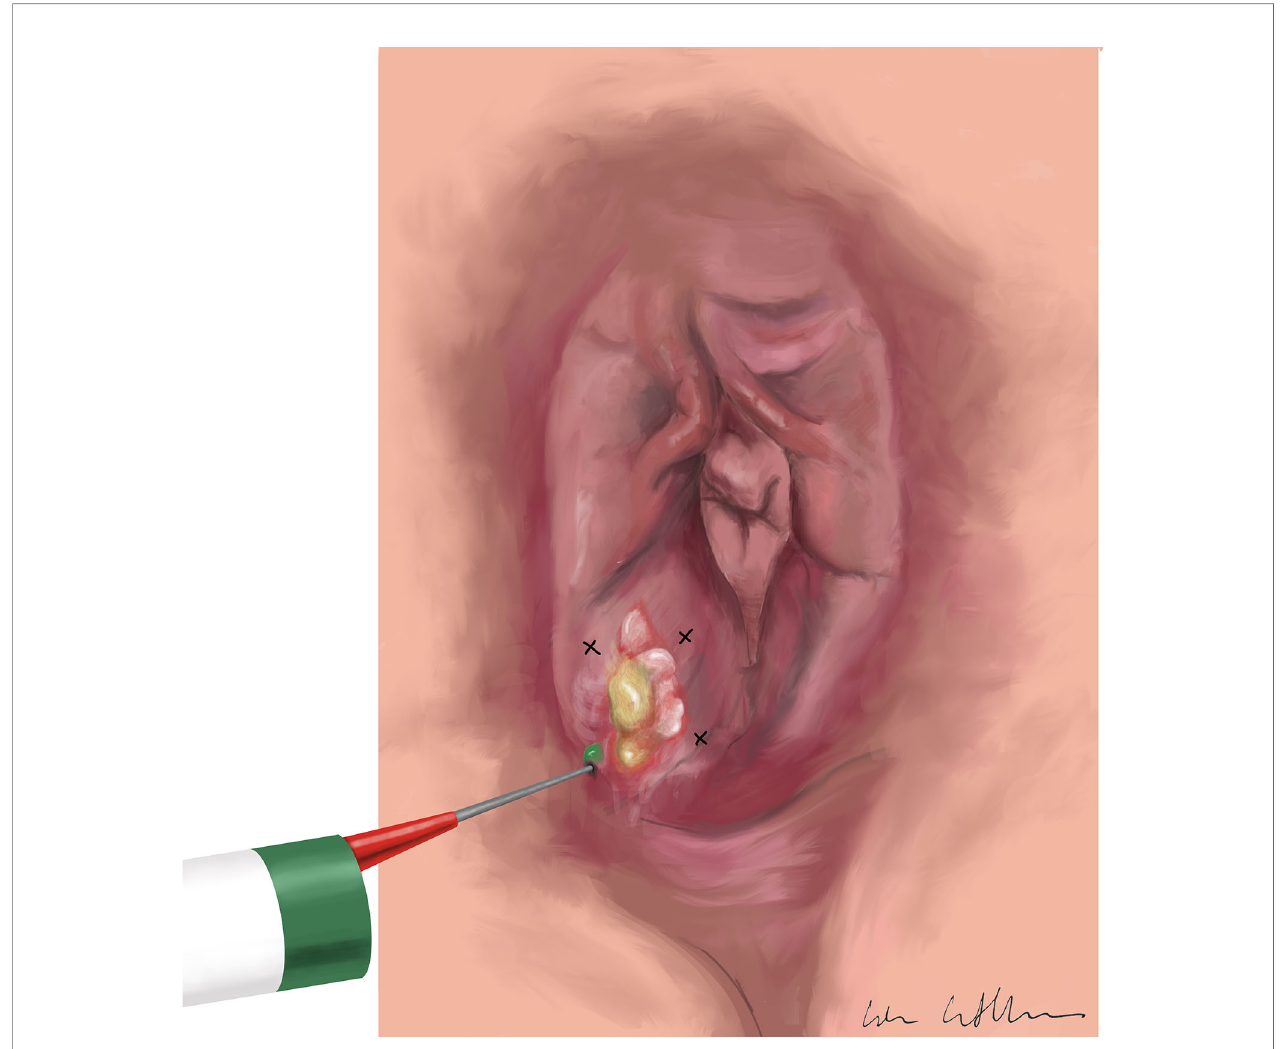
FIGURE 2 | Injection of indocyanine green intradermally at four injection sites around the